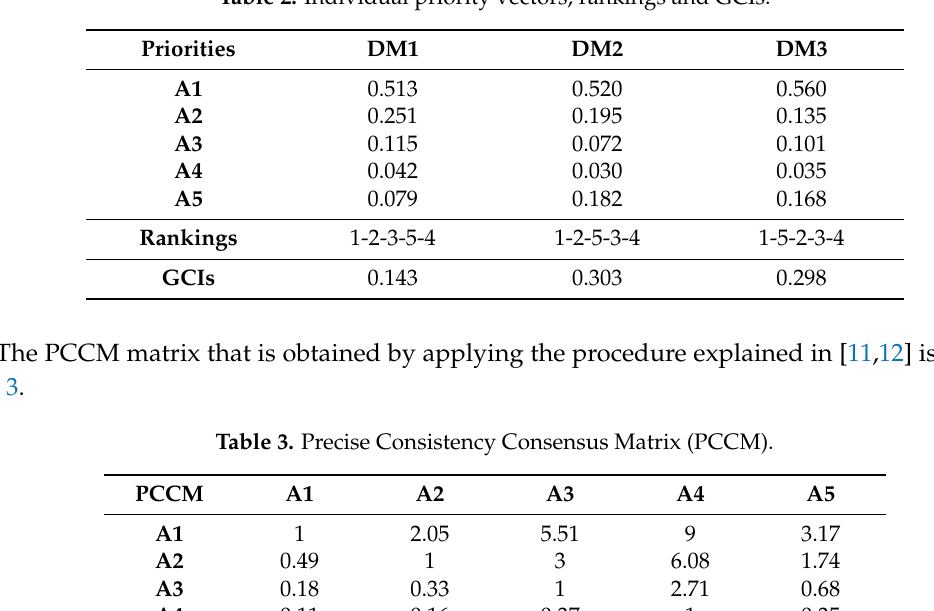
Table 2. Individual priority vectors, rankings and GCIs.